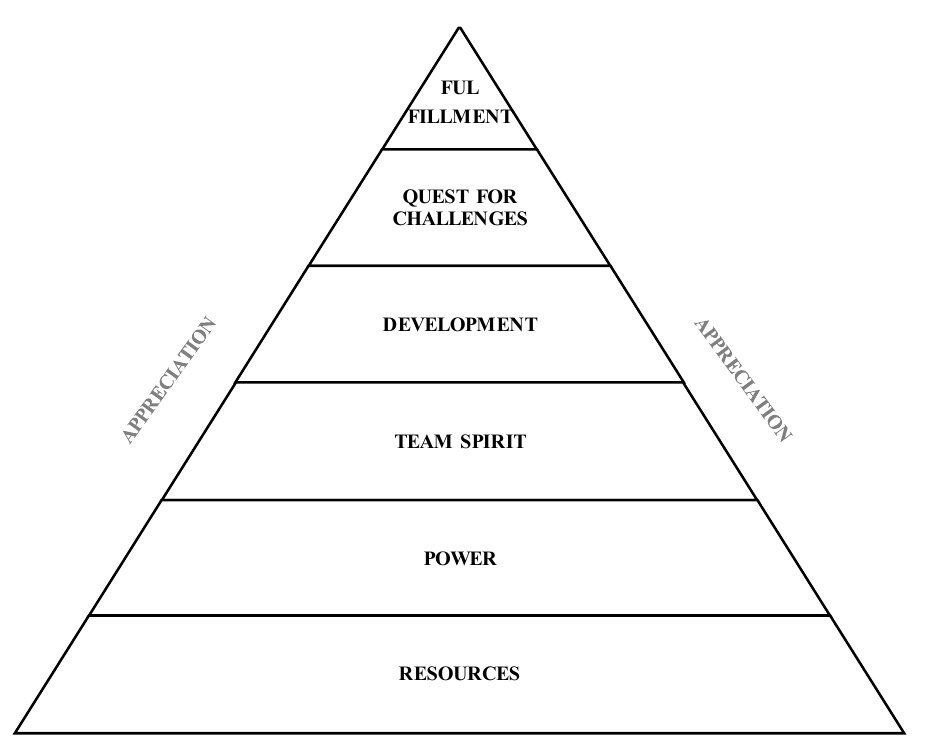
Figure 6. Our military motivation pyramid, 2021.